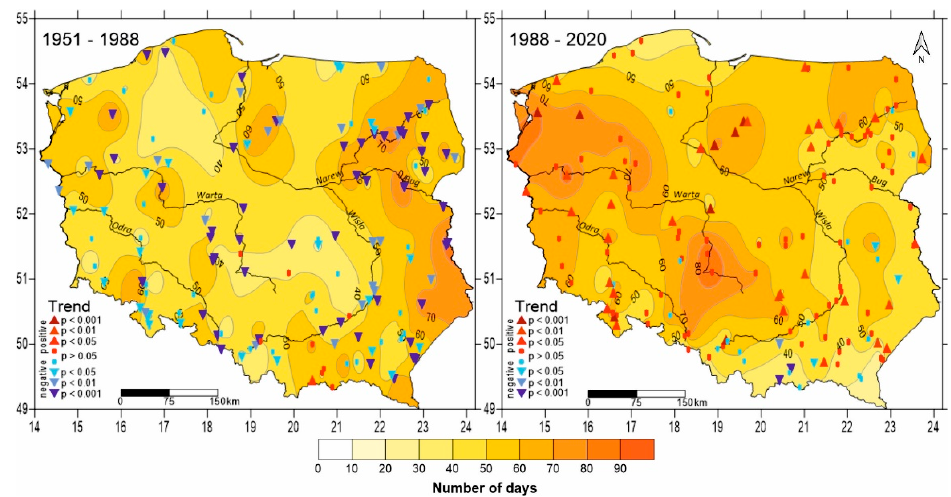
Figure 12. Spatial distribution of ND LF and the trends of changes in 1951–1988 and 1988–2020. Explanations as in Figure 11.